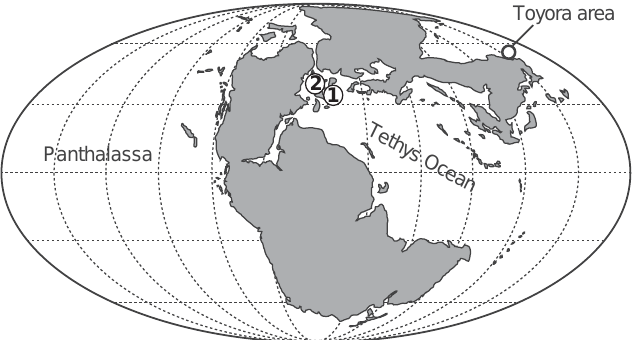
Fig. 1. Early Jurassic map illustrating the previously studied areas for ven- trally damaged ammonoids. 1, Dotternhausen, Germany (Taverne 2000; Klompmaker et al. 2009); 2, Lyme Regis, England (Andrew et al. 2010). The Toyora area was located in the northwestern part of the Panthalassa. Palaeogeographical map after Scotese